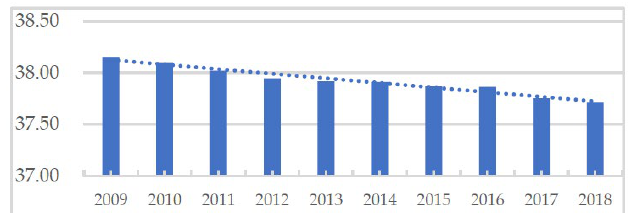
Figure 7. Changes in the eco-environmental quality index of Haikou from 2009 to 2018.